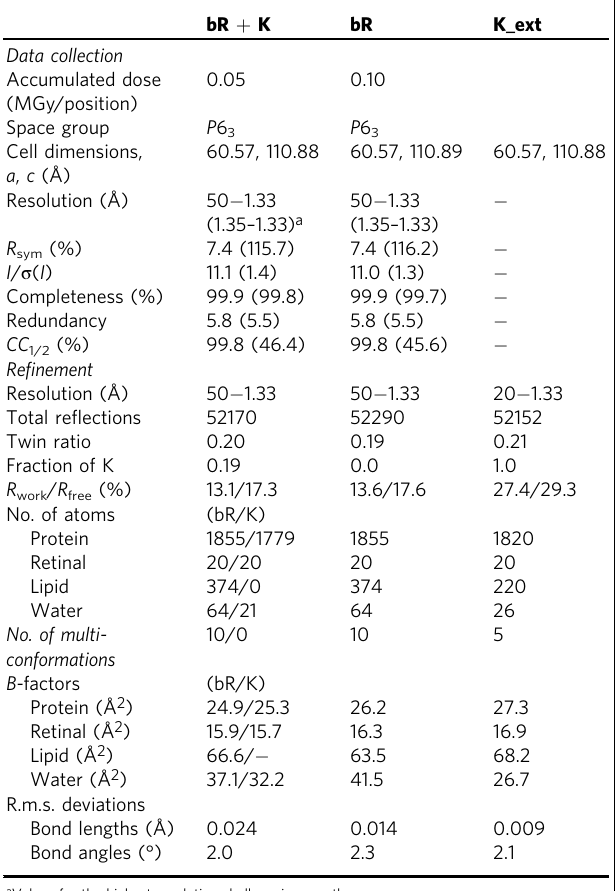
Table 1 Data collection and re fi nement